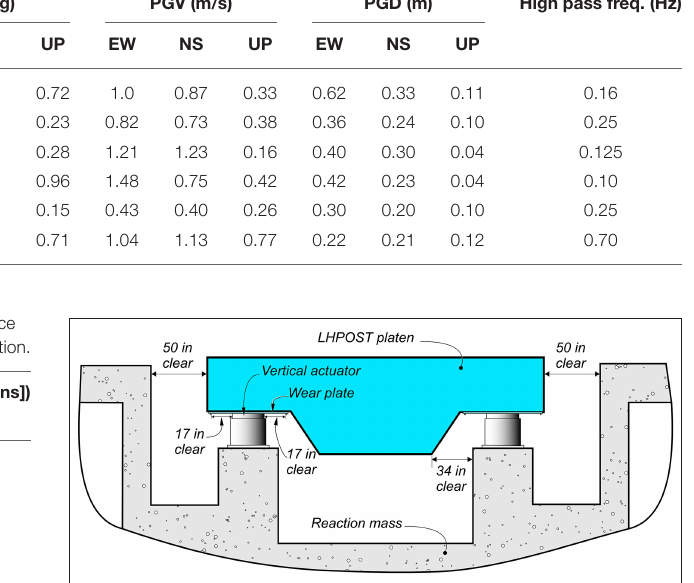
FIGURE 4 | Displacement limit in the transverse (N-S)